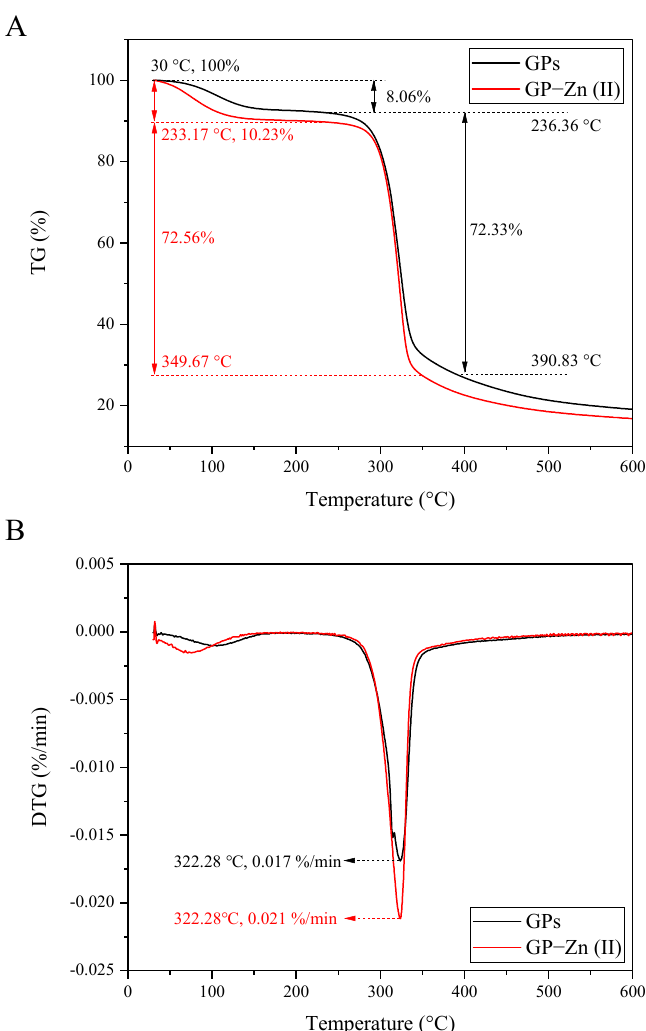
Figure 4. Thermodynamic analysis of GPs and GP–Zn (II) complexes. ( A ) TG curves; ( B ) DTG curves.